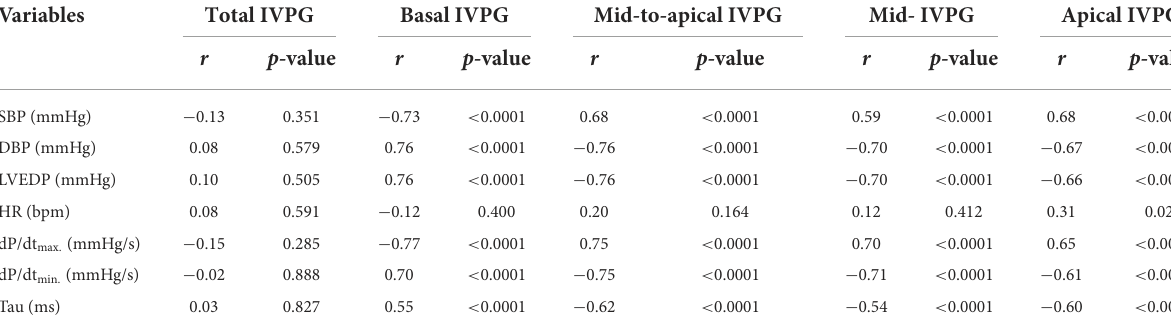
TABLE 4 Correlation between IVPG and hemodynamic (IVP) parameters. Variables Total IVPG Basal IVPG